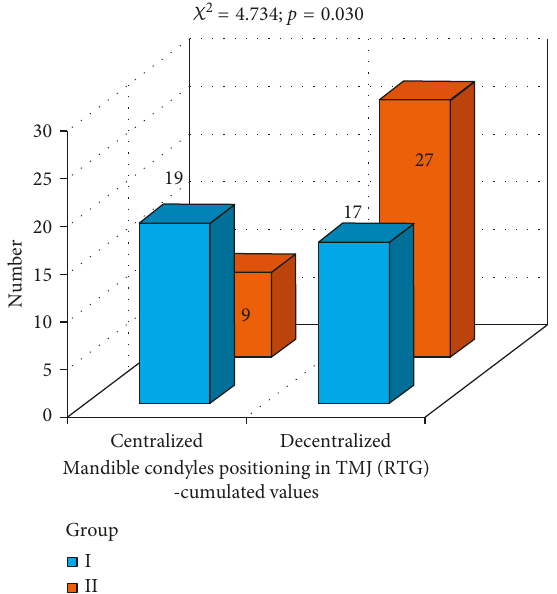
Figure 13: Evaluation of condyles centralization in group I and group II: condyles centralization and cumulated values for condyles decentralization.